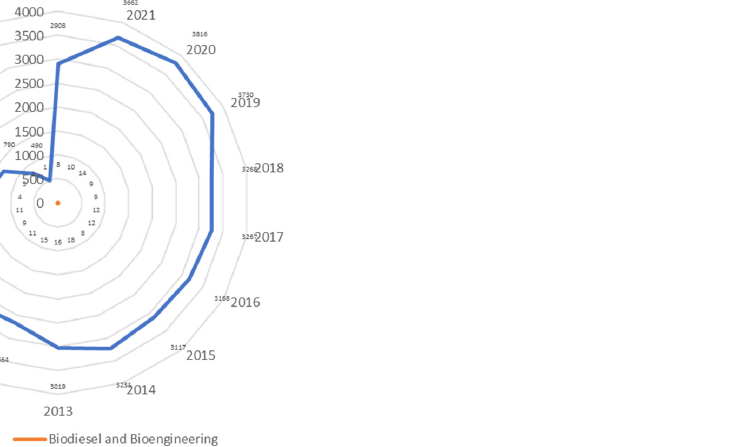
Figure 2. Number of documents published with keywords ‘biodiesel’ and ‘biodiesel and bioengineering’.